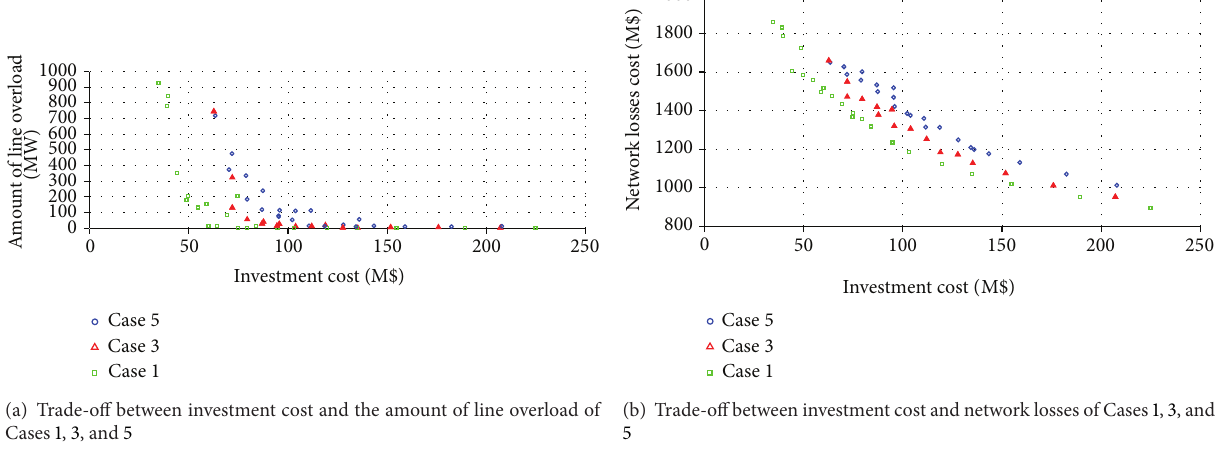
Figure 7: Trade-off graphs of Cases 1, 3, and 5.